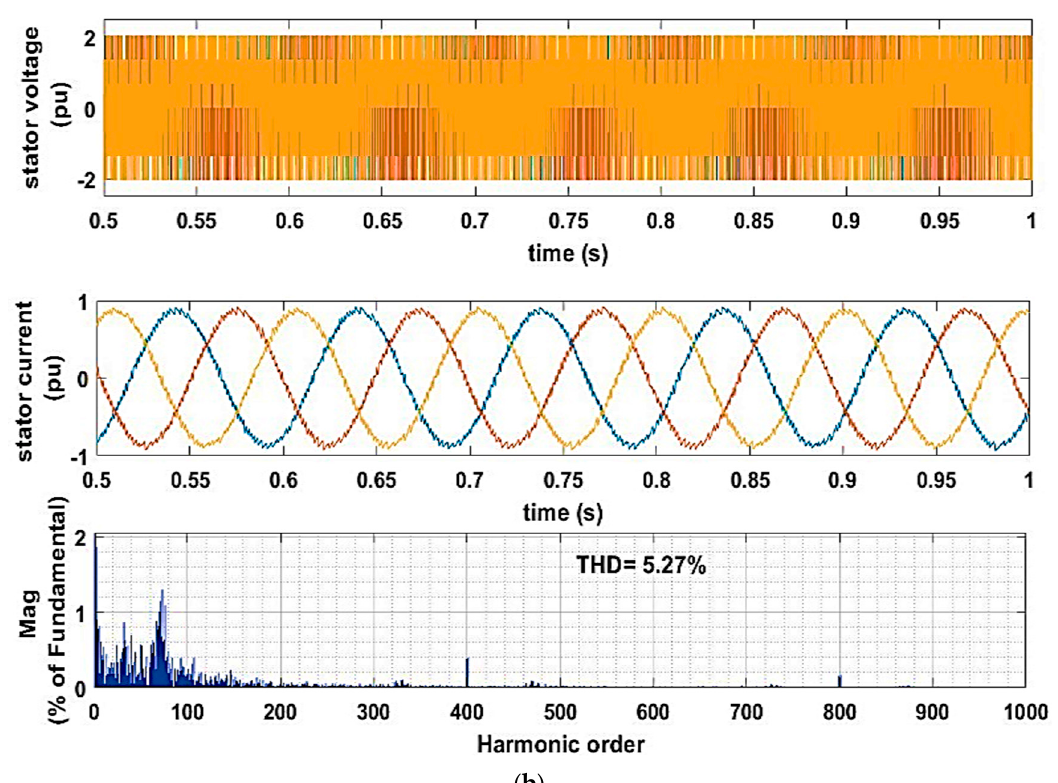
Figure 12. Simulation results: Comparison of machine-side converter voltage, current spectra and total harmonic distortions (THDs) for ( a ) conventional FCS-MPC and ( b ) Proposed MMPC.